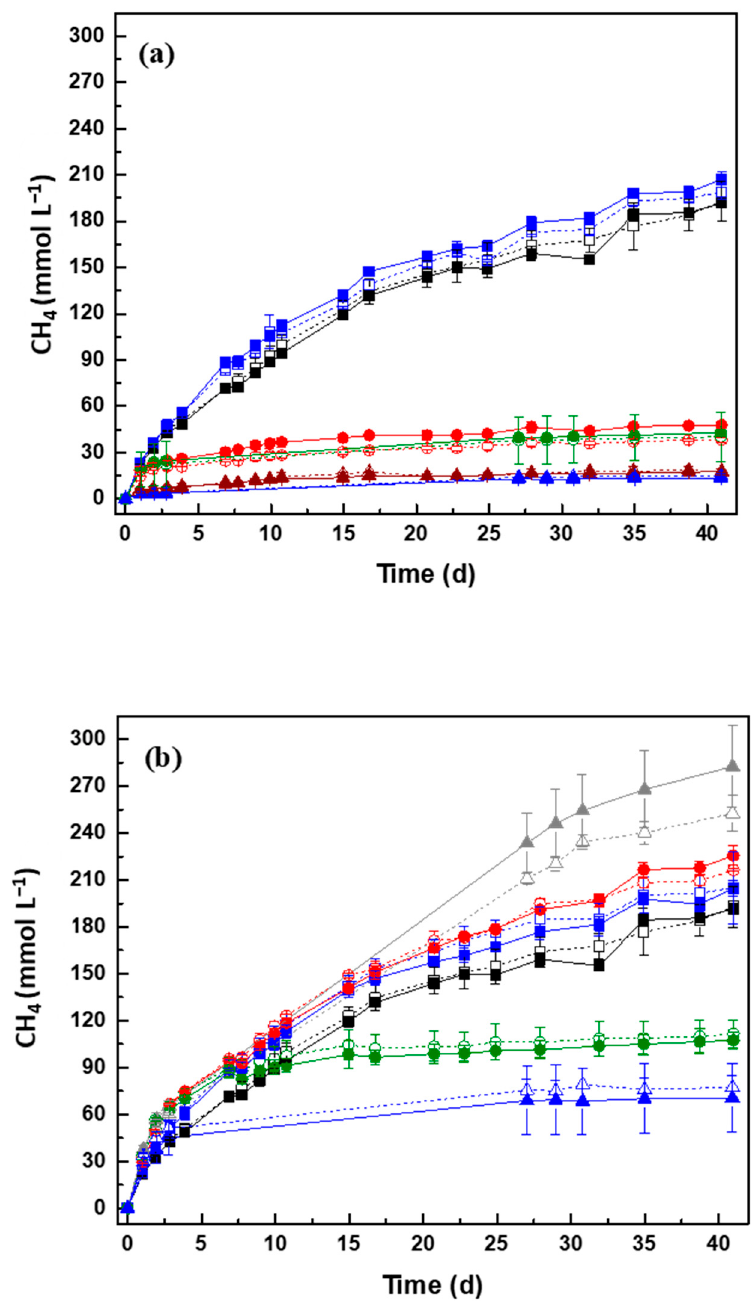
Figure 2. Biomethane production from sewage sludge (SS) contaminated with PFOA ( a ) and PFOS ( b ) in the presence and absence of activated carbon (AC) at 0.1 g L − 1 . Assays were conducted with SS without PFAS ( □ ) and SS without PFAS and in the presence of AC ( ■ ). The effect of PFAS on the BMP of SS was tested for PFOA concentrations of 0.1 g L − 1 ( □ ), 1 g L − 1 ( ○ ), 1.6 g L − 1 ( ○ ), 2 g L − 1 ( Δ ), and 3.4 g L − 1 ( ∆ ), and the effect of AC on the BMP of SS with PFOA at 0.1 g L − 1 ( (cid:4) ), 1 g L − 1 ( • ), 1.6 g L − 1 ( • ), 2 g L − 1 ( (cid:78) ), and 3.4 g L − 1 ( (cid:78) ). The effect of PFOS (b) was also assessed for concentrations of 0.1 g L − 1 ( (cid:3) ), 1 g L − 1 ( ), 1.2 g L − 1 ( ∆ ), 1.6 g L − 1 ( ), and 3.5 g L − 1 ( ∆ ), and (cid:35) (cid:35) the effect of AC on the BMP with PFOS at 0.1 g L − 1 ( (cid:4) ), 1 g L − 1 ( • ), 1.6 g L − 1 ( • ), 2 g L − 1 ( (cid:78) ), and 3.5 g L − 1 ( (cid:78)